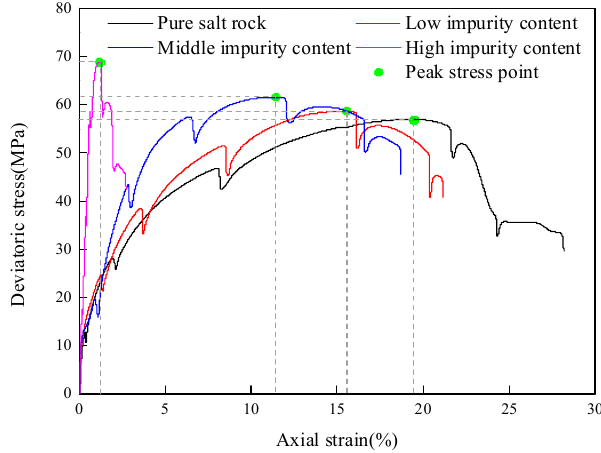
Figure 7. Stress–strain curves and peak stress points of salt rock with different impurity contents ( σ 3 = 5MPa).